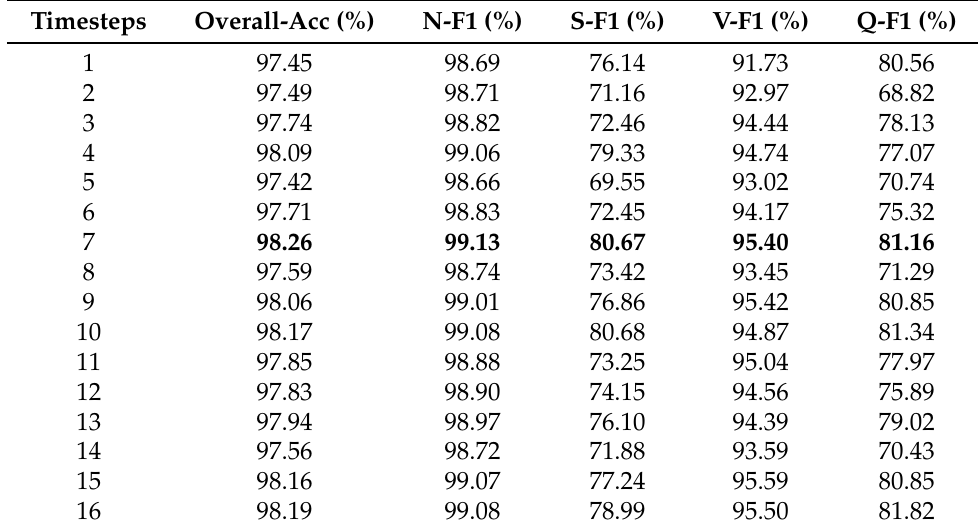
Table 2. SNN maximum accuracy with respect to the number of timesteps.